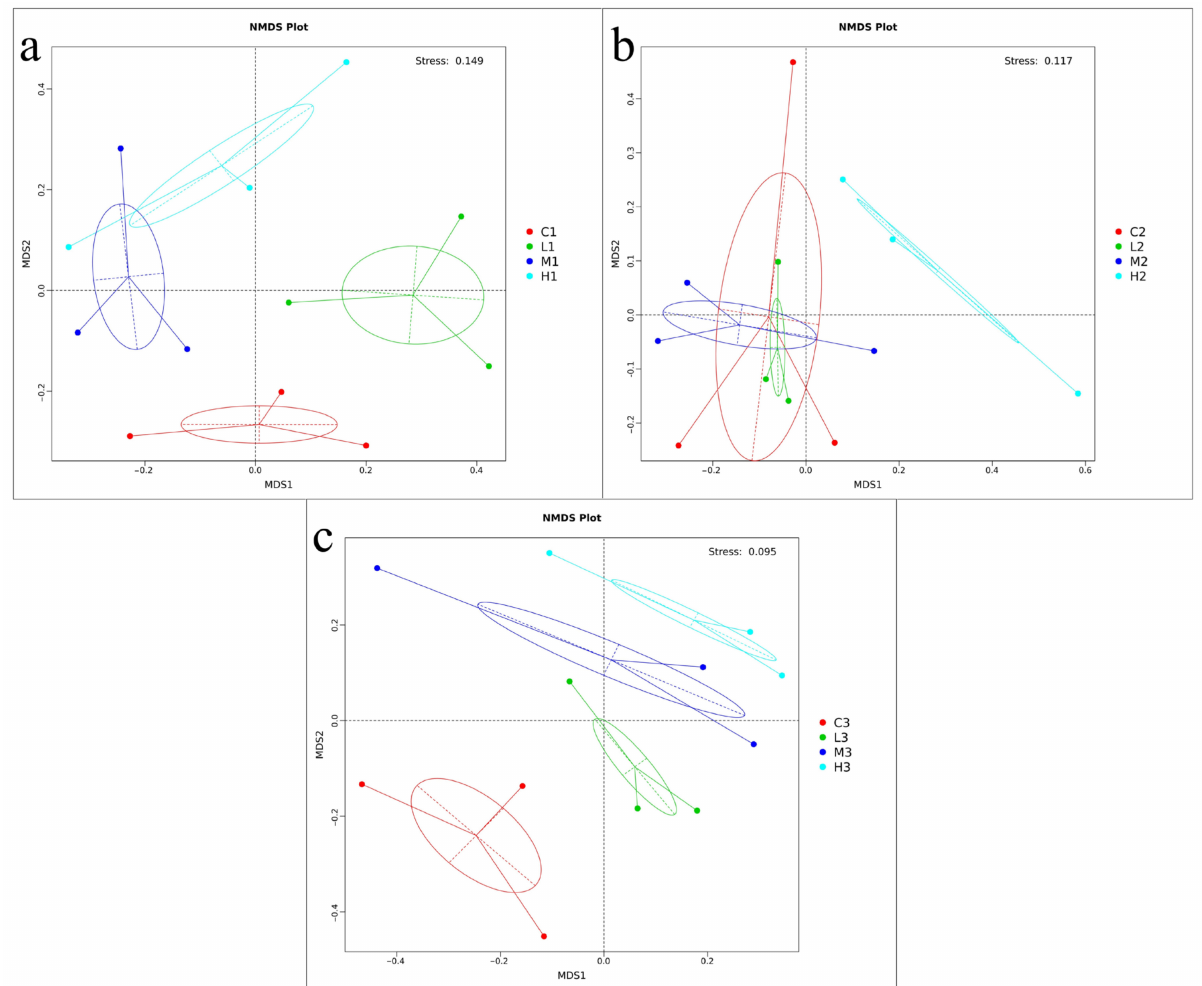
Figure 6. Comparison of bacterial community diversity across different periods and between different samples, with NMDS based on Bray − Curtis similarities (stress values are less than 0.2); ( a ) MNDS profiles of bacteria between samples at 20d; ( b ) MNDS profiles of bacteria between samples at 40d; ( c ) MNDS profiles of bacteria between samples at